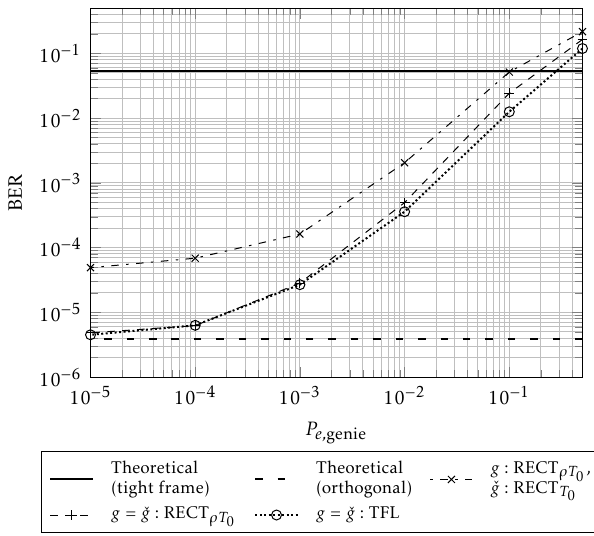
b /N 0 , with a pseudo- Figure 10. BER as a functionof P receiver, ρ = 4 / 3 and E b /N 0 = 10